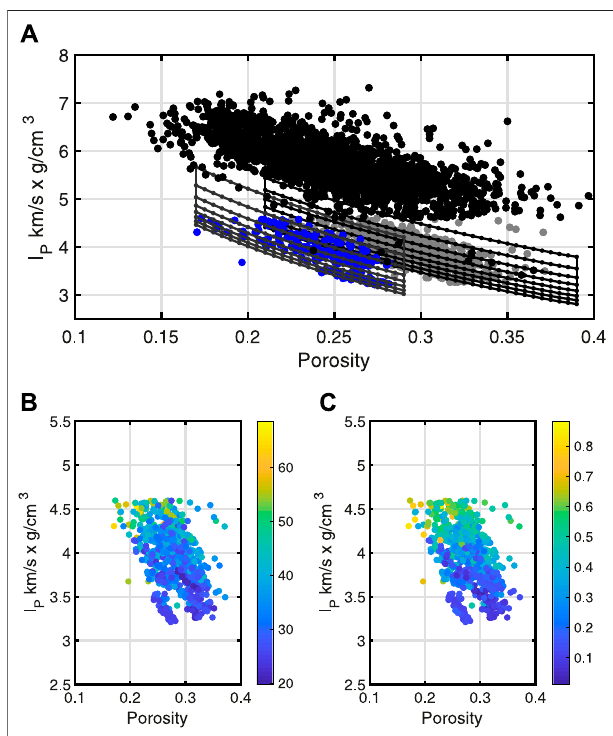
FIGURE 2| Cross plots ofP-impedance as a function of porosity. In (A) , theblackpointscorrespondtoshale,graytooilsands,andbluetogassands. A series of model lines from the soft sand model are plotted in black for the oil sands and dark gray for the gas sands. The variation in the model lines correspond to porosity in the horizontal direction and water saturation in the vertical. Plots with shading contain only the oil and gas sands color coded by gamma ray (B) and water saturation (C) .